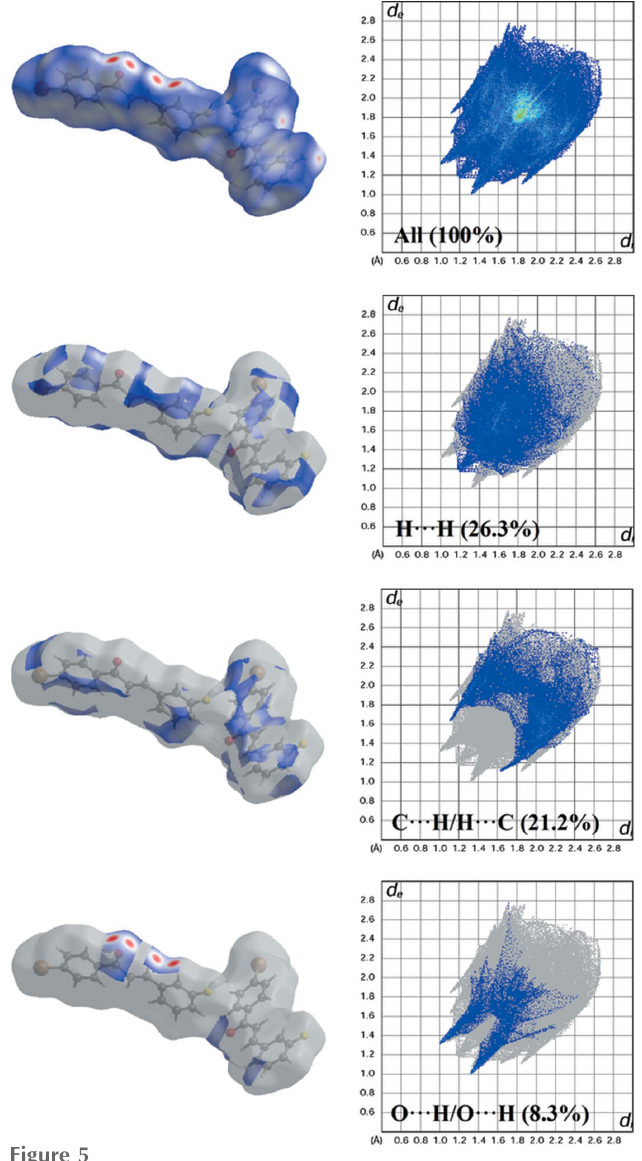
Figure 5 Two-dimensional fingerprint plots with a d norm view showing the percentage contributions to the total Hirshfeld